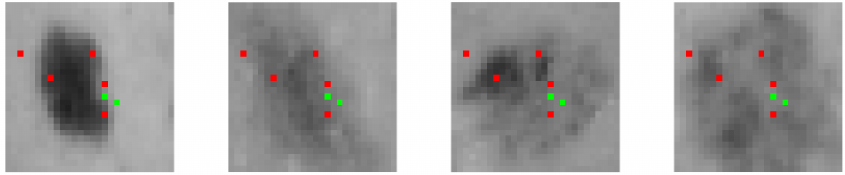
Figure 9. An example of four training samples belonging to the “malignant” class, correctly classified by the same rule extracted from a discretized interpretable convolutional network (DICON).